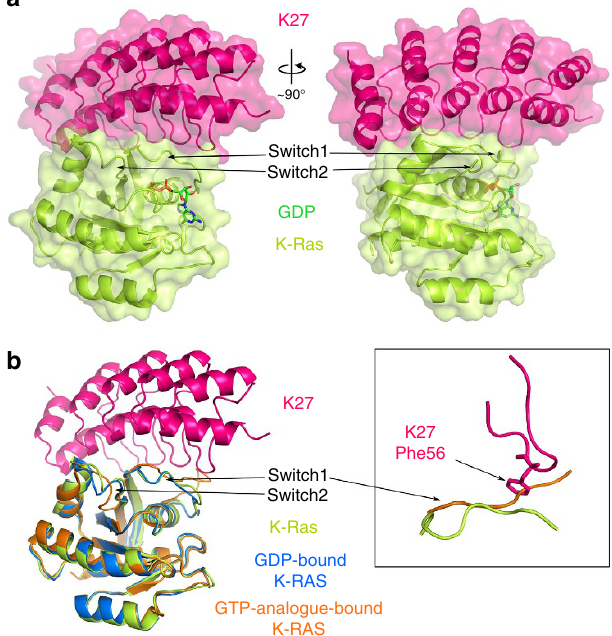
Figure 2 | Crystal structure of the nucleotide exchange inhibitor DARPin K27 binding to K-Ras G12V at 3.2Å resolution. DARPin K27 is shown binding to the inactive form of K-Ras G12V, crystallized in the presence of GDP ( a ). Two views of the complex are shown, rotated at 90 (cid:2) about a vertical axis, with switch 1 and 2 regions annotated. Comparison of the Ras G12V/DARPin K27 complex with unbound Ras G12V structures in the GDP (PDB code: 4TQ9) and GTP analogue-bound (PDB code: 4EFM) states ( b ). Ras in the DARPin K27 complex (green) aligns well with unbound GDP Ras (blue) particularly in the switch 1 loop, whereas GTP analogue-bound Ras (orange) shows the expected conformational change in the switch 1 loop which predicts a clash with the phenylalanine sidechain at position 56 in K27 (see